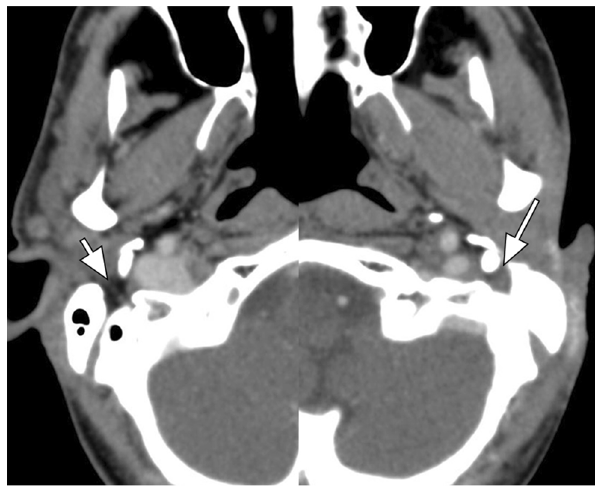
Fig. 8 Axial CTcomposite image shows obliteration of the fat pad at the left stylomastoid foramen ( long arrow ), compared to the normal fat pad on the right ( short arrow ). This finding is suggestive of PNTS along CN VII in particular in a patient with history of skin or parotid